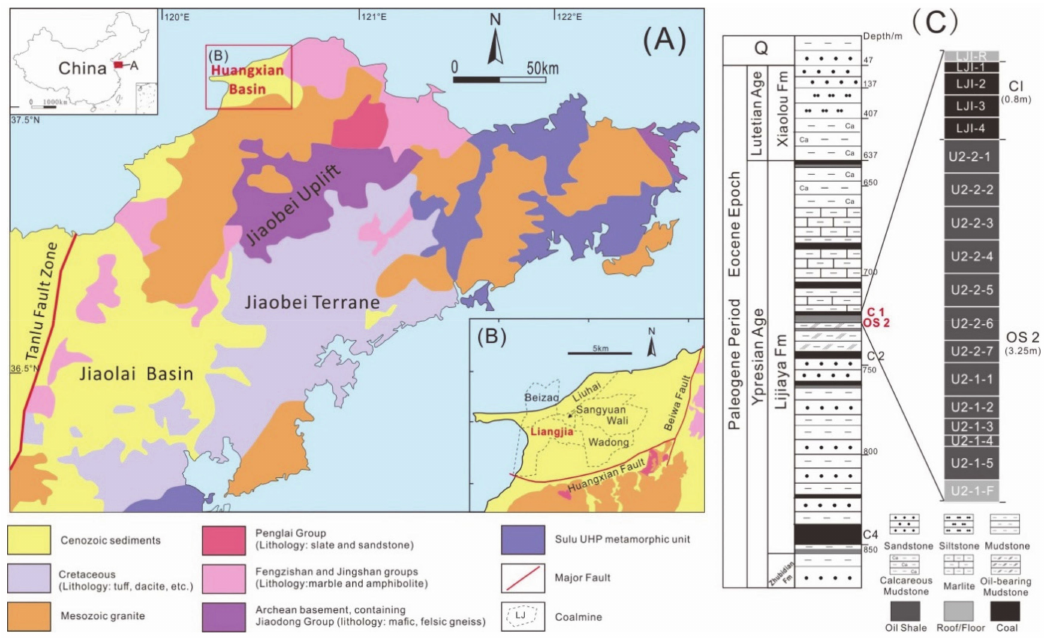
Figure 1. Palaeogeography, location, andsedimentarysequenceofLiangjiaCoalMine. ( A )Palaeogeographic map of East Shandong Province, modified from Lv et al. [13,15,17]; ( B ) Location of the Liangjia Coal